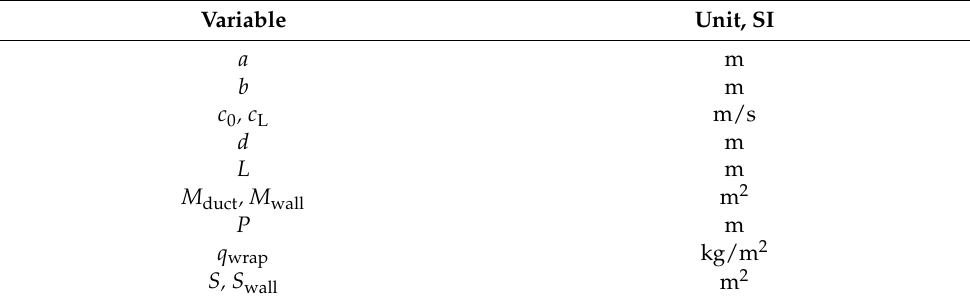
Table A1. Units for different variables.